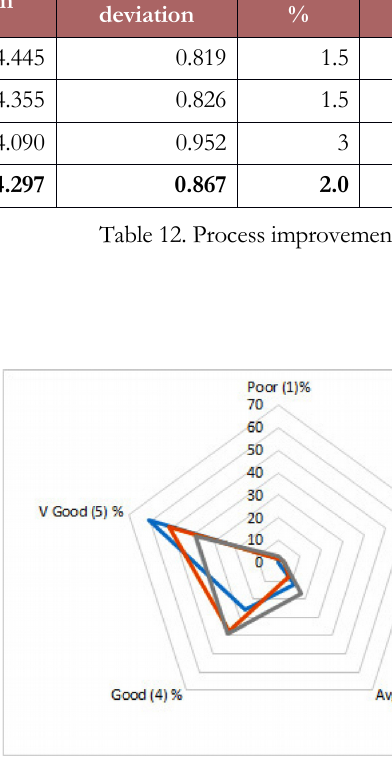
Figure 7. Radar diagram on process improvement